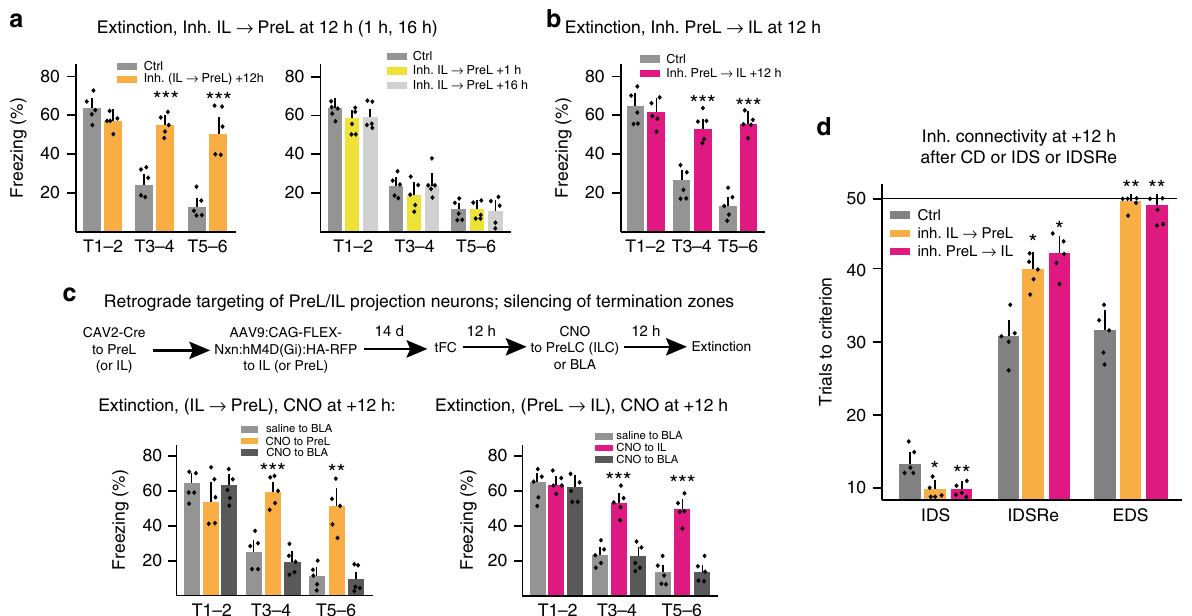
Fig. 7 Reciprocal PreL ↔ IL activity at + 12 – 14 h drives IL function. a, b Impact of inhibiting IL → PreL ( a ) or PreL → IL ( b ) projection neurons at + 12 h after acquisition on subsequent extinction learning. Repeat measure two-way ANOVA; ( a ) n = 5 each; Cntrl vs. + 12 h, F (1, 4) = 13.63, ** P ; ( b ) Cntrl vs. + 12 h, F (1, 4) = 19.21, ** P . Silencing IL → PreL at + 1 h or + 16 h after acquisition did not affect subsequent extinction learning ( a ; n = 5 each; repeat measure two-way ANOVA: + 1 h vs. + 16 h, F (2, 8) = 1.869, P = 0.197, ns ). Sidak ’ s post hoc test for ( a, b ). c Local silencing of IL → PreL or PreL → IL projecting axon collaterals in their termination zones at + 12 h after acquisition of tFC. Top: schematic of experimental strategy (expression of Neurexin-inhibitory DREADDs fusion protein). Bottom: Suppression of extinction learning by silencing of IL → PreL or PreL → IL collateral terminals in PreL (or IL), but not BLA. Repeat measure two-way ANOVA; n = 5 each; IL → PreL: Inh. PreL vs. BLA, F (2, 8) = 97.73, *** P ; PreL → IL: Inh. IL vs. BLA, F (2, 8) = 85.86, *** P . Tukey ’ s post hoc test for C. d Impact of silencing IL → PreL or PreL → IL projection neurons at + 12 h after CD, IDS, or IDSRe learning on subsequent IDS, IDSRe, or EDS learning. Repeat measure two-way ANOVA; n = 5 each; Inh. IL → PreL vs. PreL → IL, F (2, 8) = 36.61, *** P ; Tukey ’ s post hoc. Error bars: SEM; post hoc; P < 0.05 ( * ), 0.001 ( ** ), 0.0001 ( ***